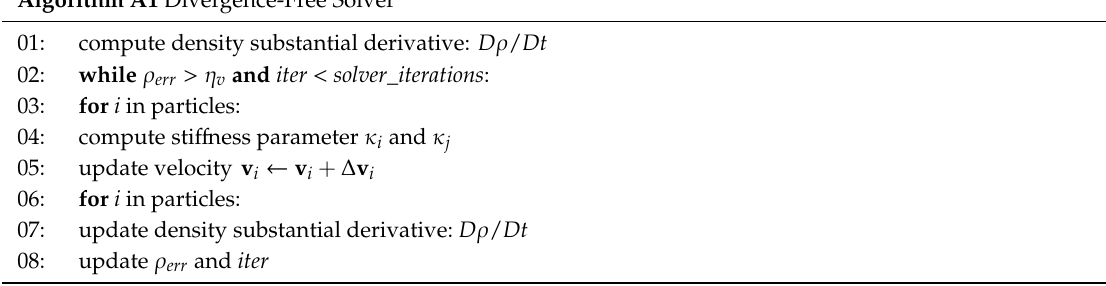
Algorithm A1 Divergence-Free